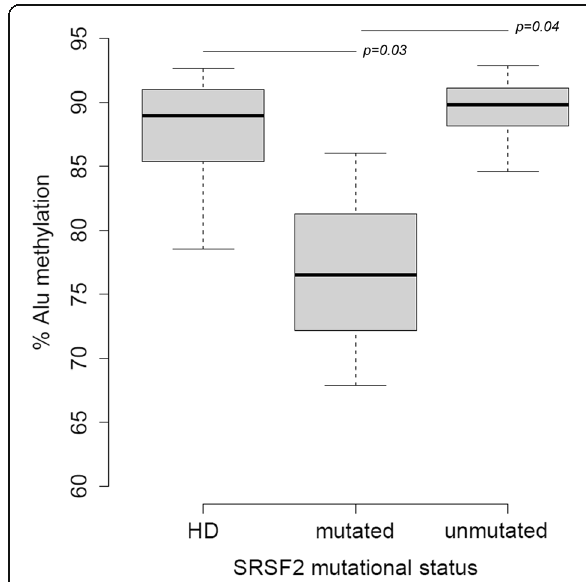
Fig. 5 Alu DNA methylation levels in CMML patients. Alu methylation analysis of a small cohort of CMML patients compared with HD, and in relation to the presence of the SRSF2 hotspot (c.284C>D). HD, healthy